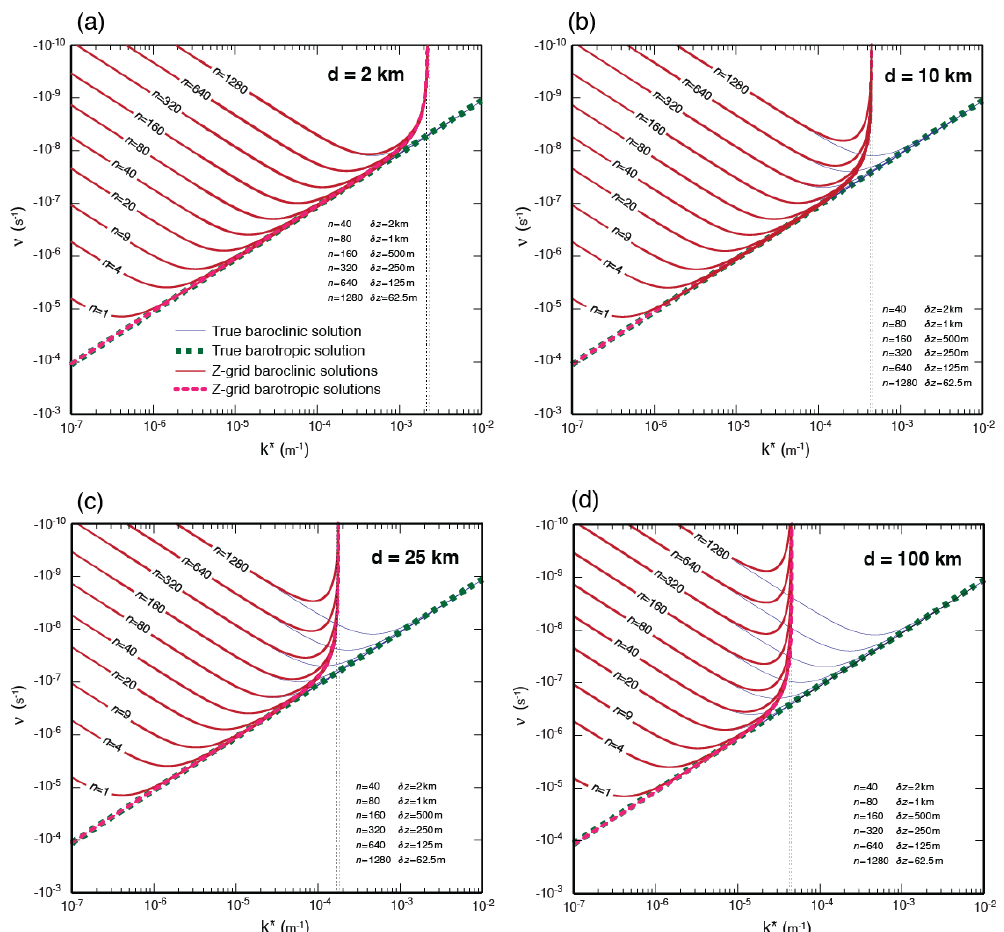
Figure 1. Plots of the absolute value of frequency of the baroclinic (red lines) and barotropic (dashed red lines) Rossby modes obtained on the Z grid for the grid spacings (a) 2km, (b) 10km, (c) 25km and (d) 100km, and for the various vertical wavenumbers. The thin blue and thick green dashed lines are the corresponding true baroclinic and barotropic frequencies,